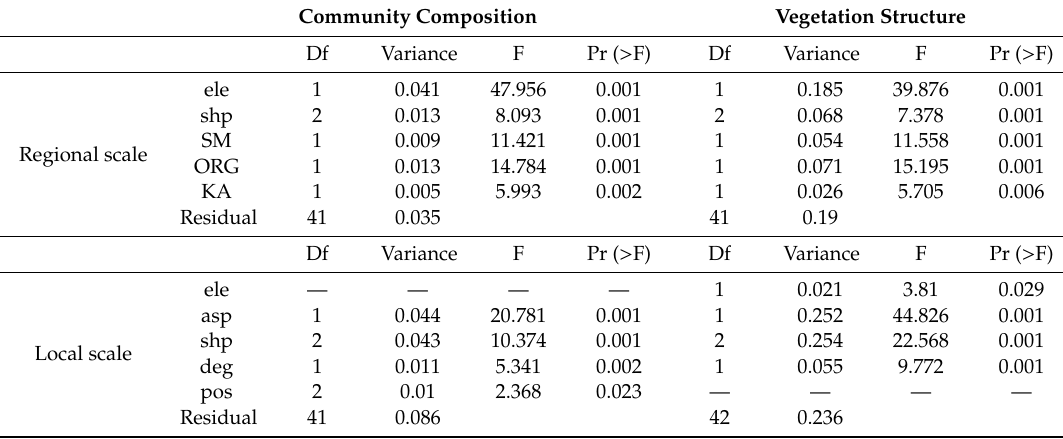
Figure 2. Variation partitioning for ( a ) community composition and ( b ) vegetation structure based on soil, topography, regional (XY), and local (dbMEM) spatial processes. (Non-significant: NS; Numbers in brackets are R 2adj explained by the specific processes). Table 3. Result of scale-specific identification of relevant environmental variables based on ANOVA test of redundancy analysis model.